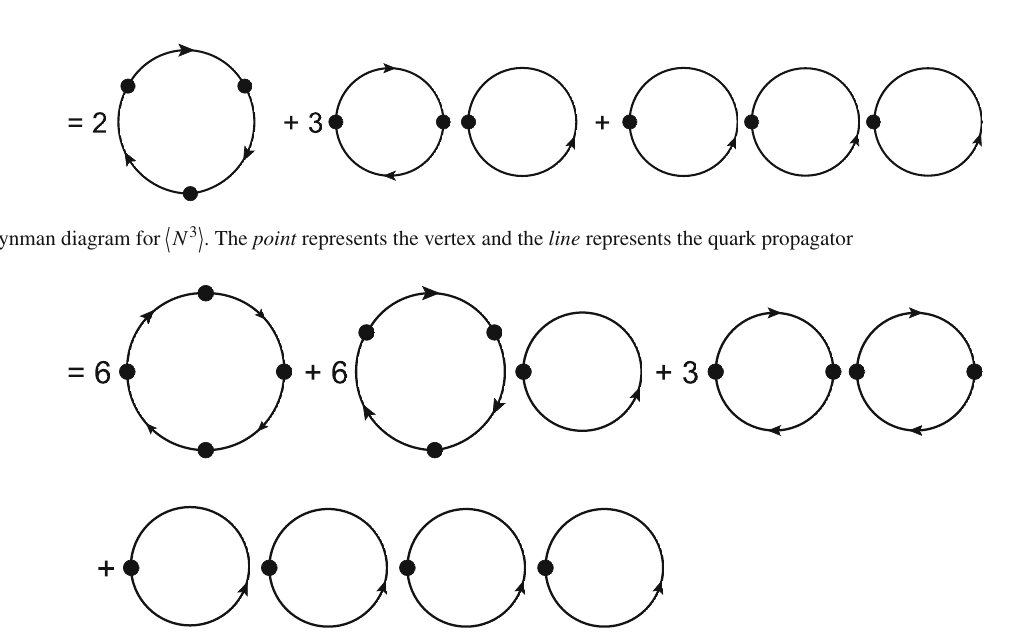
Fig. 3 Feynman diagram for